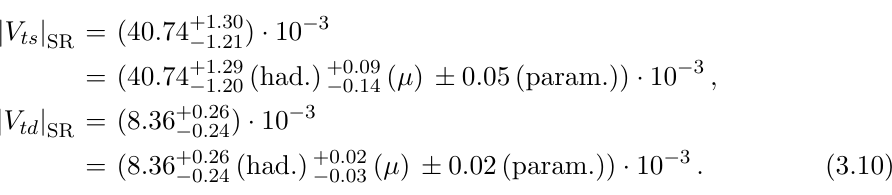
Figure 6 . Our predictions (blue) for the mass and decay rate di(cid:11)erence in the B s (left) and B d (right) systems are compared to the current experimental averages and the predictions (red) based on the latest lattice averages from FLAG [18] for f 2 f 2 B q with i 6 = 1 and h R 0 i . The weighted average over the sum rule and lattice results is shown Q i B q in black. We indicate the updated Run 1 and Run 2 combinations for (cid:1)(cid:0) s presented by LHCb [50] and ATLAS [51] at Moriond EW 2019 by shaded gray